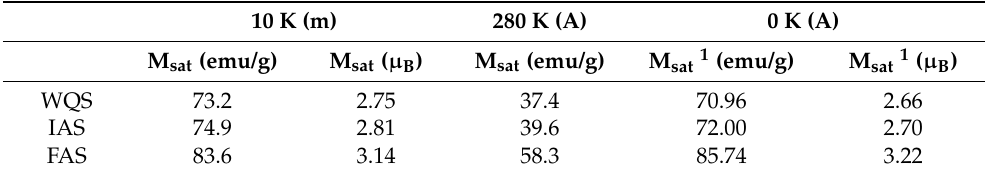
Figure 5. Magnetization vs. magnetic field curves for samples of alloy Cu5 quenched from 1020 K in WQS, IAS, and FAS ageing states recorded at ( a ) 10 K and ( b ) 280 K. Table 1. Saturation magnetization of ferromagnetic martensite and austenite obtained by means of the Arrott plots, together with the calculated values for austenite at 0 K.